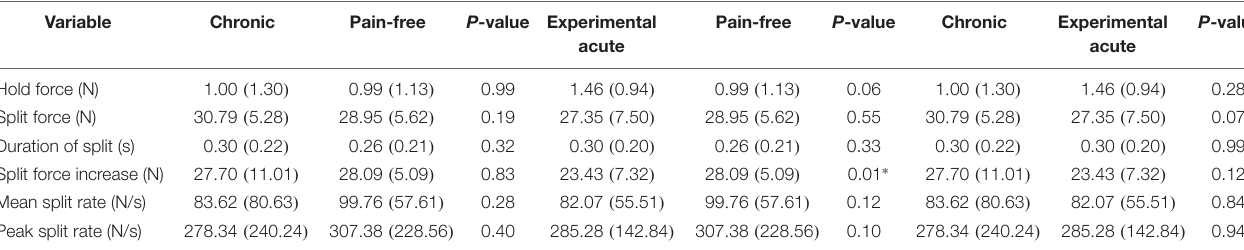
TABLE 3 | Comparisons between the three conditions regarding force, duration, and rate